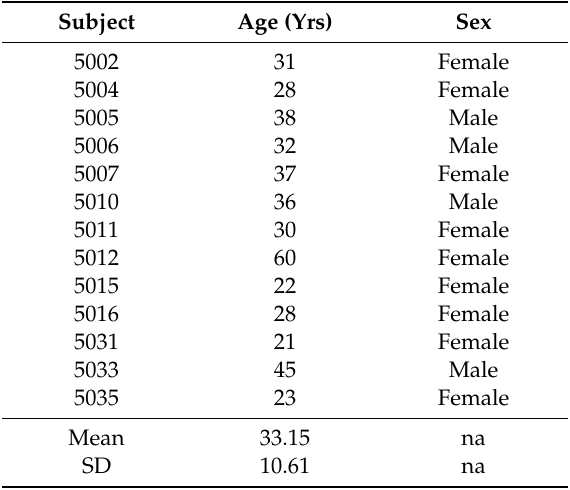
Table 2. The pulsatility of the cervical venous flow rate (range –8.89 to − 15.71 mL / s; mean (SD) P I = 0.56 (0.23); mean (SD) RI = 0.43 (0.14)) was less (p < 0.001) than that of the arterial flow rate (range 8.36